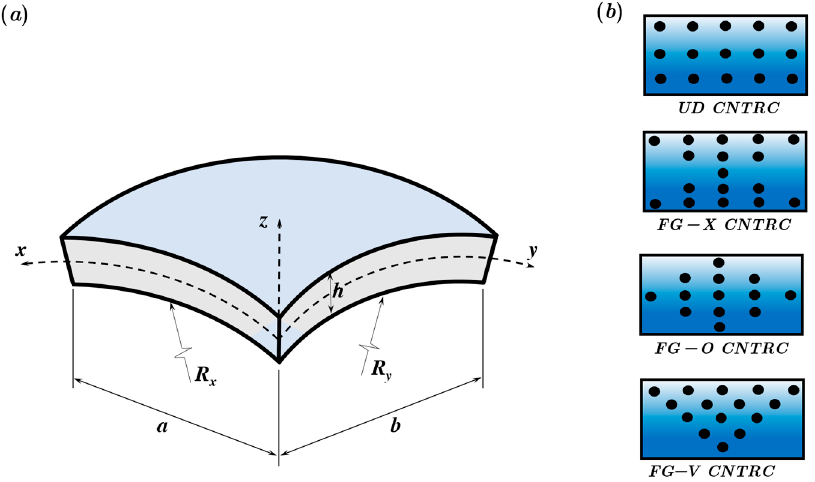
Figure 1. Material properties, geometry and coordinate system ( a ) and gradation type ( b ).